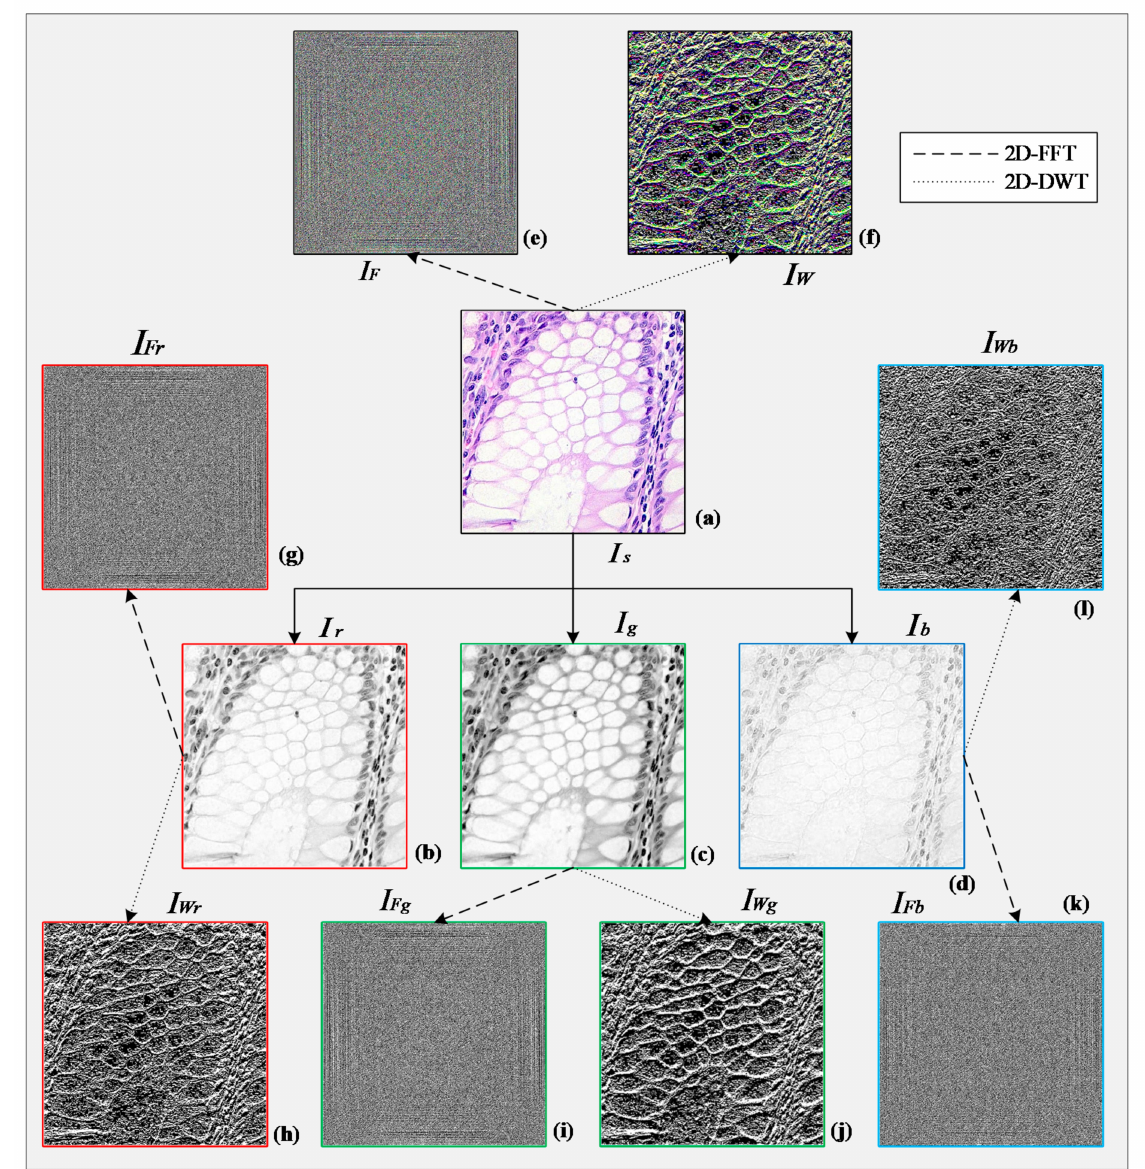
Figure 3. ( a ) A sharpened histopathological image; ( b ) red, ( c ) green, and ( d ) blue channel illustration of ( a ); ( e ) 2D-DFT and ( f ) 2D-DWT output of ( a ); ( g ) 2D-DFT and ( h ) 2D-DWT output of ( b ); ( i ) 2D-DFT and ( j ) 2D-DWT output of ( c ); and ( k ) 2D-DFT and ( l ) 2D-DWT output of ( d